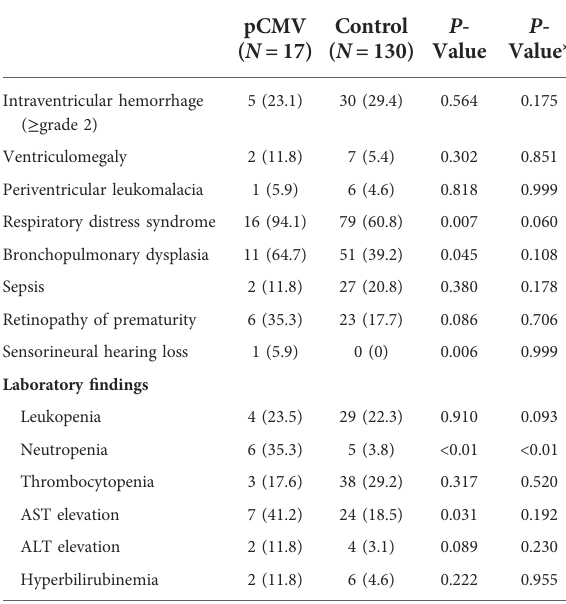
TABLE 2 Clinical course and outcomes of the postnatal cytomegalovirus infection and control